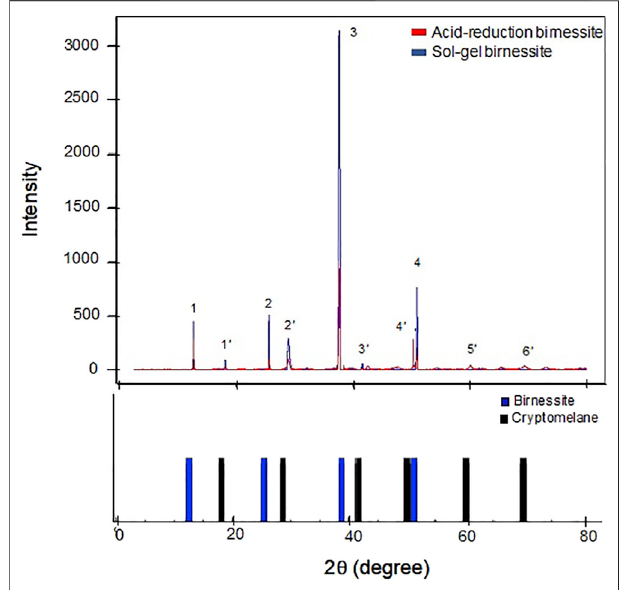
FIGURE 3 | XRD spectra for the two birnessite types used in the experiment (upper panel). Lower panel represents the characteristic peaks of birnessite (blue) and cryptomelane (black) from the American Mineralogist crystal structure database (Downs and Hall-Wallace, 2003).